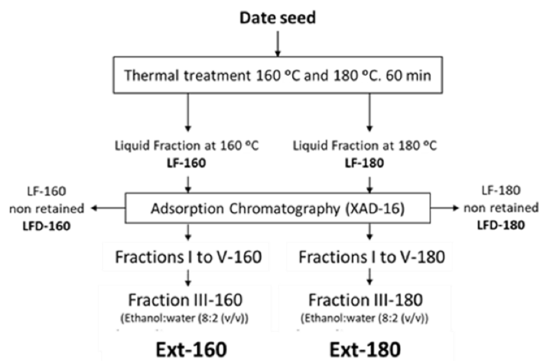
Figure 1. Treatment scheme for date seed samples and the main fractions studied.